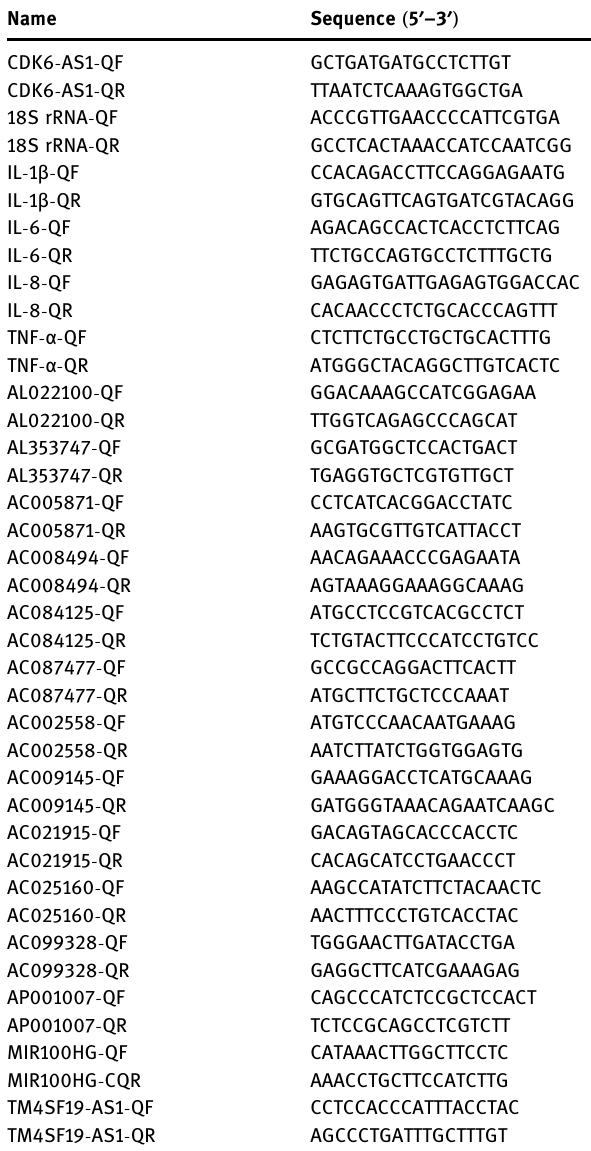
Table 2: The primers for qPCR